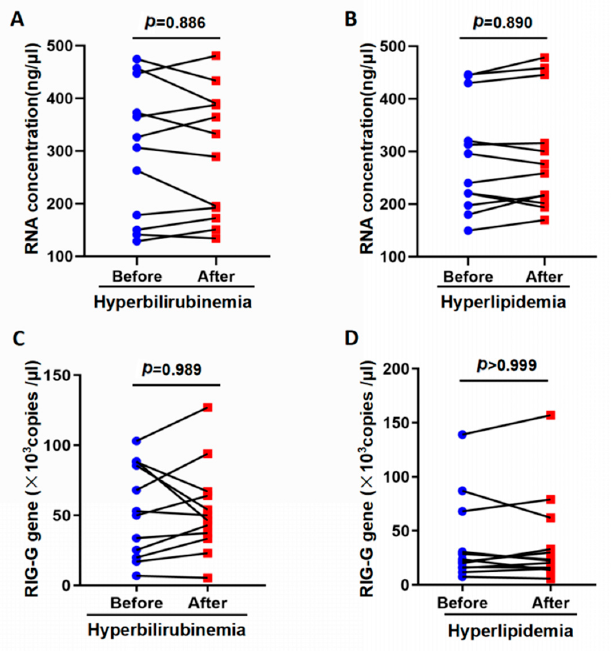
Figure 2. Hyperbilirubinemia and hyperlipidemia have no significant interference in detecting RIG gene in peripheral blood. ( A , B ) Hyperbilirubinemia and hyperlipidemia samples were obtained by direct extraction of RNA or extraction following plasma exchange to remove bilirubin and lipids. The results are expressed as the mean ± SD ( n = 12, p > 0.05). ( C , D ) Use of the established qPCR method to detect RIG-G gene, showed that hyperbilirubinemia and hyperlipidemia had no significant effect (n = 12, p >